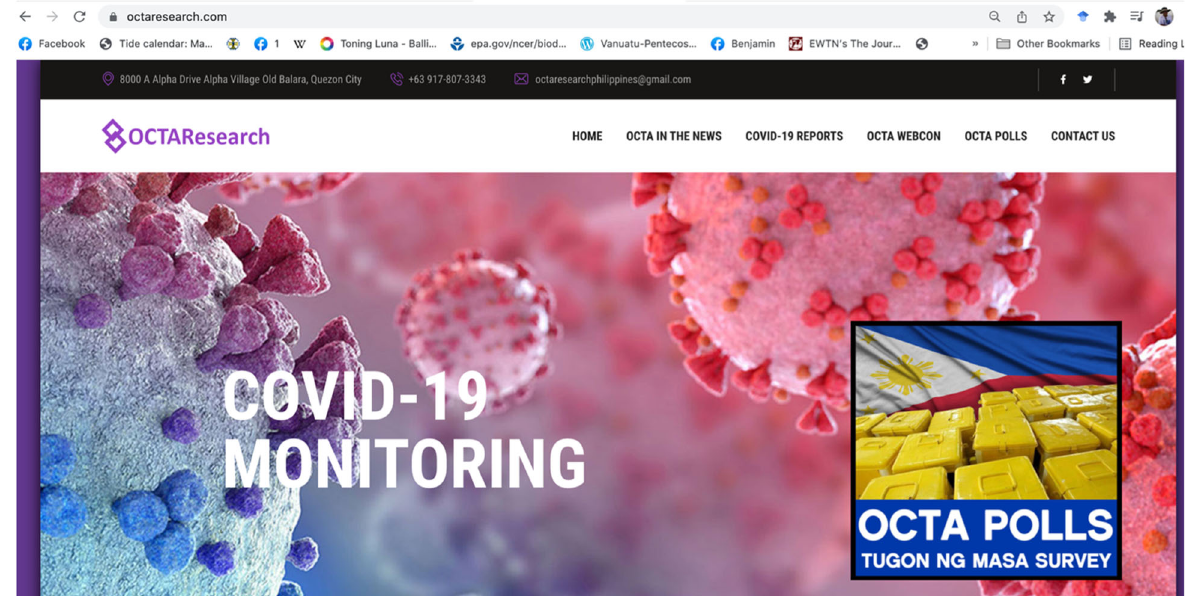
Fig. 1 OCTA Research website informing about its two services, COVID-19 monitoring and polling. OCTA is a primarily polling organization but has taken on COVID-19 monitoring, forecasting and advice